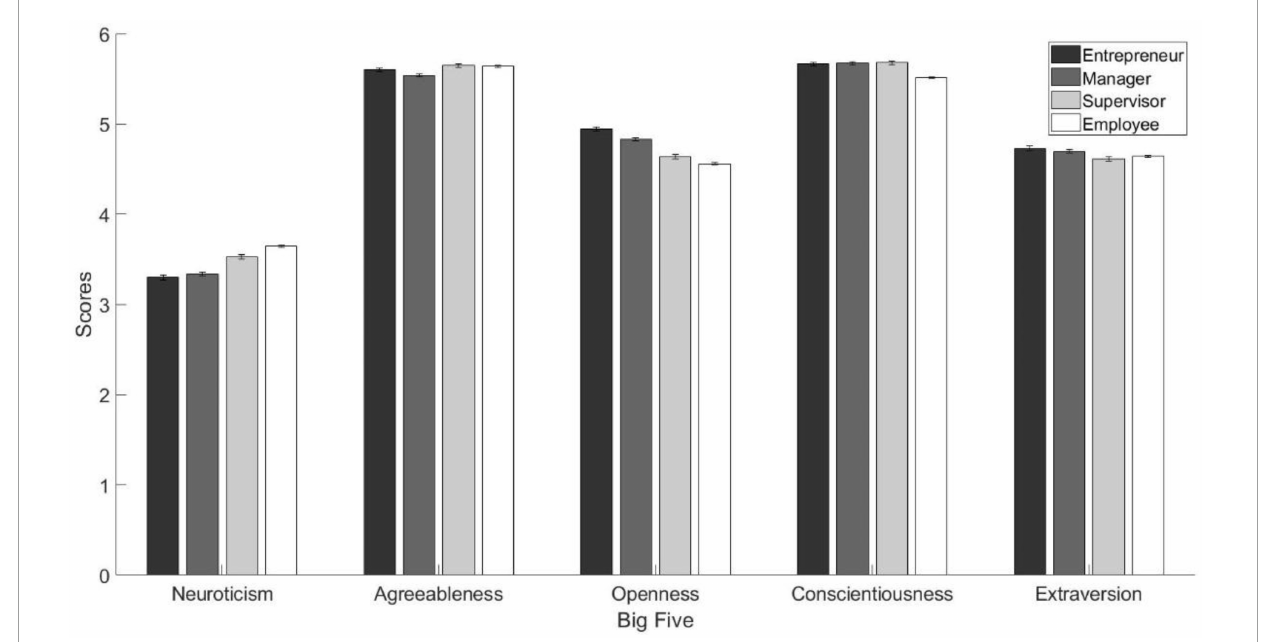
FIGURE1 The bar graph shows differences in personality traits between different employment statuses with standard error.